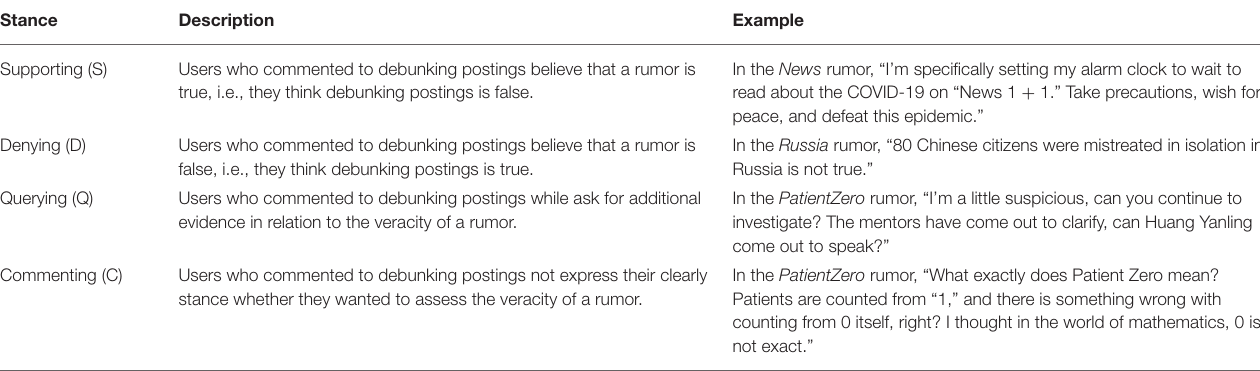
TABLE 2 | Coding scheme for four stances (Translated into English from Chinese). Stance Description Example Supporting